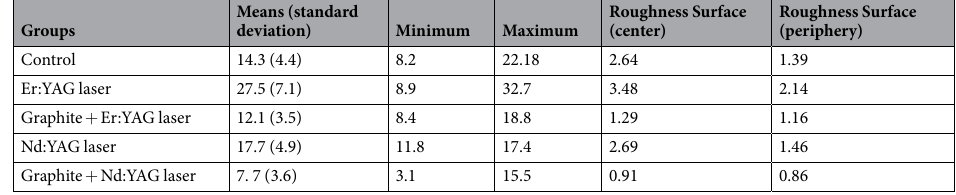
Table 2. Mean (standard deviations) tensile bond strength values (in MPa) and surface roughness results (R a , in µ m) for the control and experimental groups.